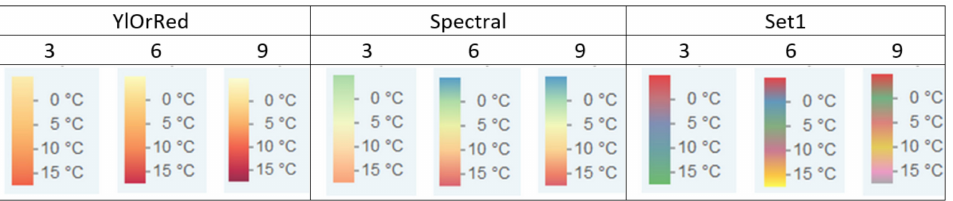
Figure 7. The range of colors in YLOrRd, Spectral, and Set1 color schemes with three, six, and nine colors’ classes.